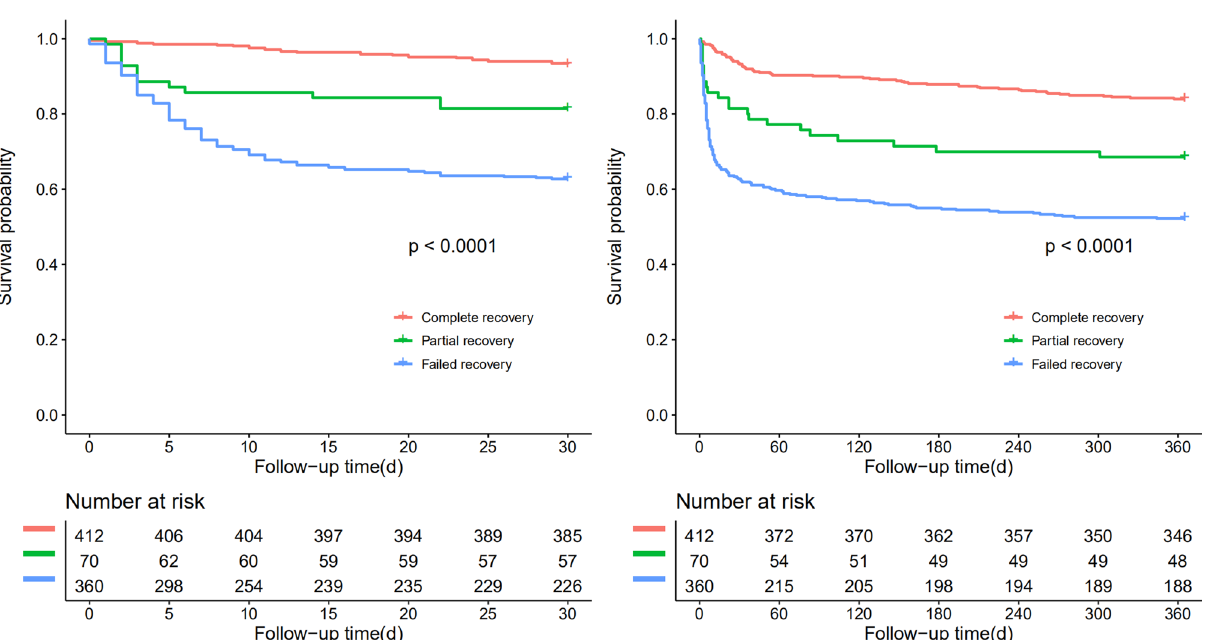
Figure 3. Patient survival within 30 days and 1 year of patients at discharge having different renal function status. Follow-up time (day): refers to the time since the AKI of